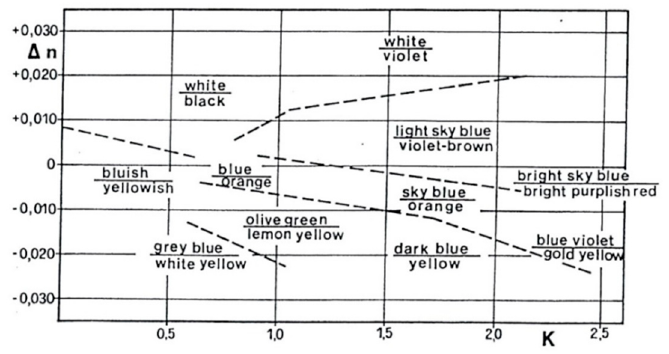
Figure 2. Table of color effects [28] published by Staub, 1955.